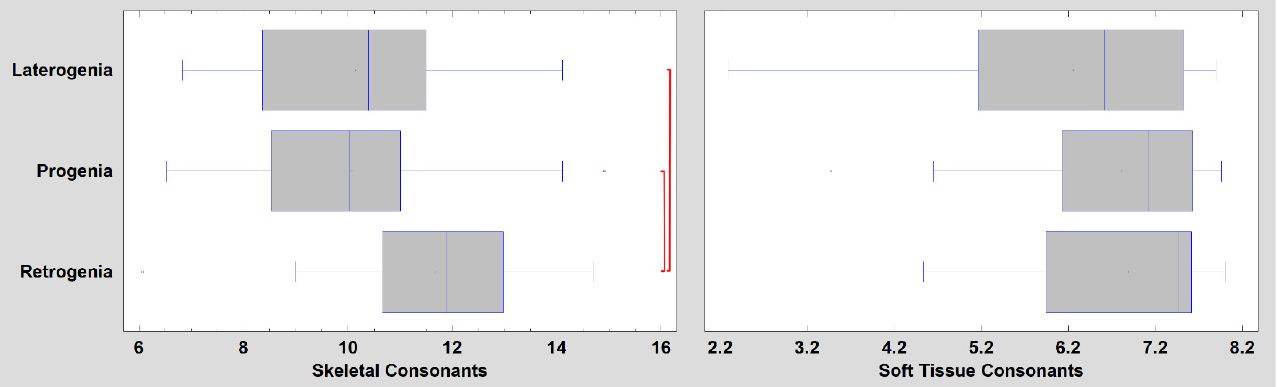
Figure 4. Effects of skeletal deformity on Skeletal Consonants and Soft Tissue Consonants. The pronunciation quality of Skeletal Consonants in patients affected by Skeletal Class III was significantly worse than in Class II patients. Red brackets indicate groups between which there is a significant difference in the quality of consonant articulation ( p < 0.01).